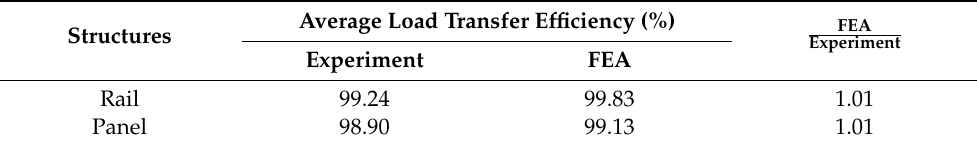
Figure 14. Load-displacement results of assembly test and finite element analysis (Load Case II), ( a ) vertical displacement of the right rail (mm), and ( b ) vertical displacement of the panel (mm). Table 8. Comparison of average LTE.